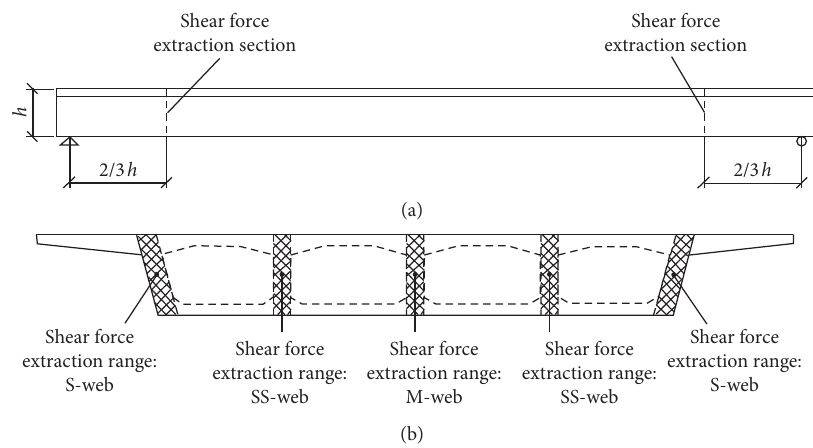
Figure 3: Shear force extraction locations for each